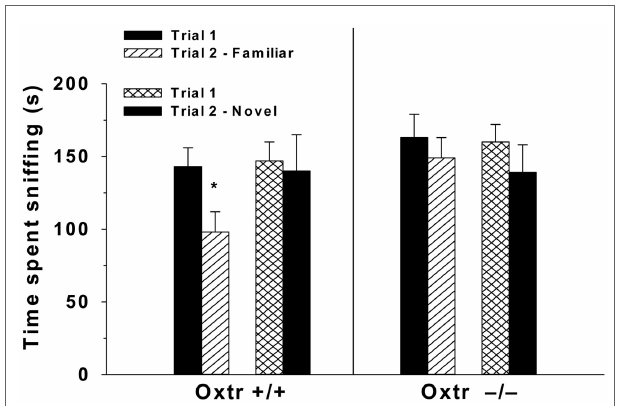
FiguRe 2 | Oxtr − / − mice have impaired social recognition . In a two-trial discrimination task performed over 2 weeks, Oxtr + / + ( n = 8) and Oxtr − / − males ( n = 8) were exposed to overiectomized BALB/C female mice during trial 1, and then 30 min later during trial 2 they were exposed to a familiar female on week 1. During week 2 of testing after trial 1, mice were exposed to a novel female during trial 2. Oxtr − / − mice fail to discriminate between the familiar and novel female spending approximately equal amounts of time sniffing both; compared to Oxtr + / + mice that spend more time sniffing the novel female. Reprinted with permission from Endocrinology, Lee et al.